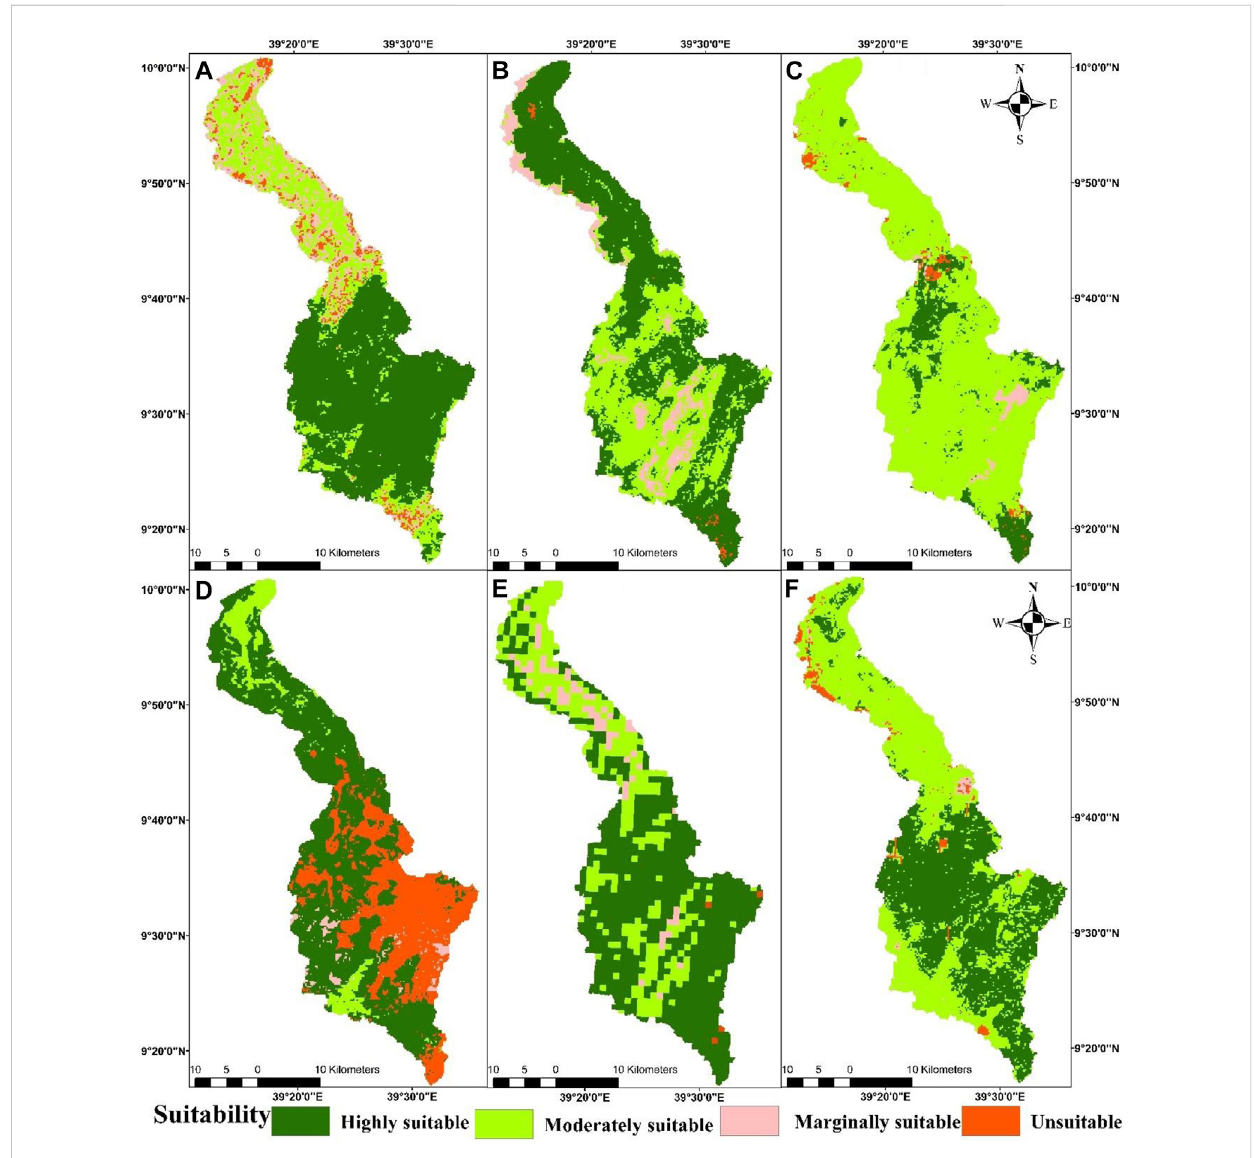
FIGURE 6 Surface irrigationsuitabilitydeterminedbasedonvariousfactors,including: (A) SoilpH; (B) Soildrainage; (C) Soiltype; (D) Soil texture; (E) Soildepth; and (F) Electrical conductivity of Soil